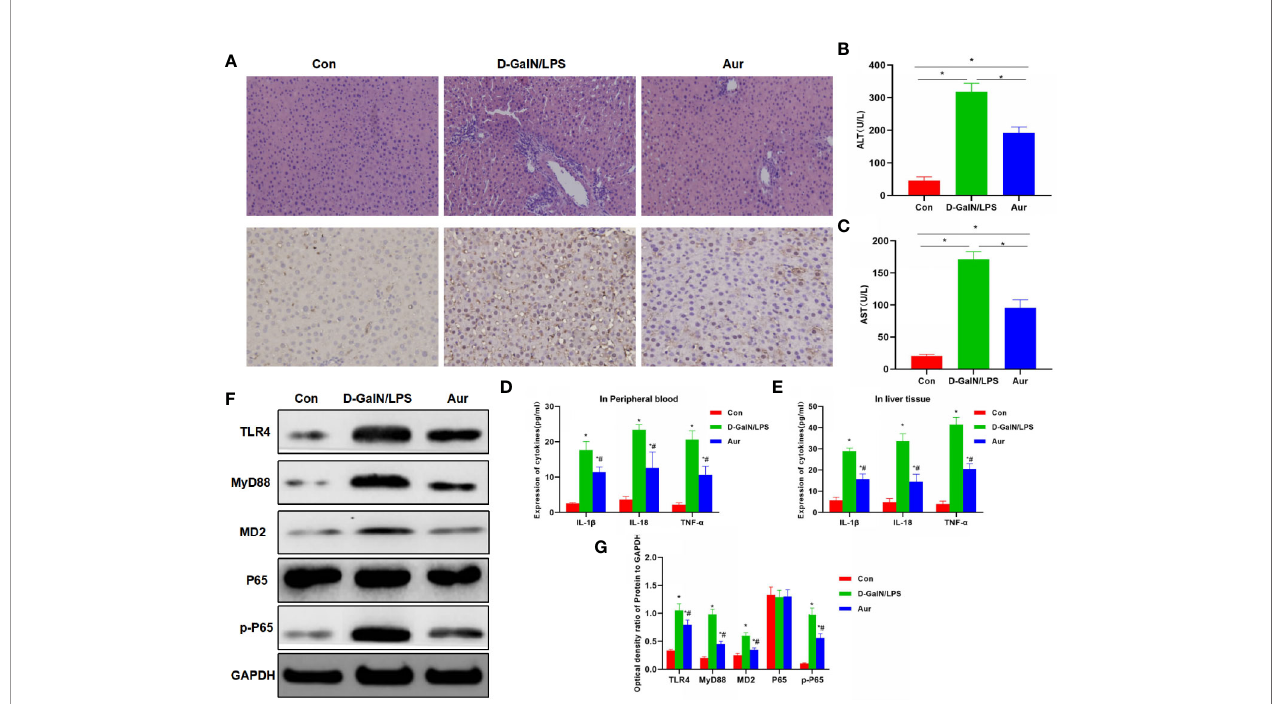
FIGURE 5 | Effect of Aur on ALI in mice. (A) : Effects of Aur on tissue pathology and MD2 expression of liver in mice (n = 5): There was no signi fi cant liver injury in mice from the Con group, with relatively low expression of MD. In the LPS/D-GalN group, there was an in fl ammatory response, tissue edema, and signi fi cantly increased expression of MD2 in the liver tissue, while the tissue in fl ammatory response was relieved and MD2 expression was downregulated in the Aur group. (B, C) : Alteration of ALT and AST expression in mice (n = 10): The expression of ALT and AST was relatively low in the Con group, which was upregulated in the LPS/D-GalN group, but was downregulated in the Aur group. Comparison between groups, *P <0.05. (D, E) : Changes in the expression of in fl ammatory factors in the peripheral blood and liver tissues of mice (n = 10): The expression of in fl ammatory factors, including IL-18, IL-1 b , and TNF- a was relatively low in the Con group, which was upregulated in the LPS/D-GalN group, but was downregulated in the Aur group. Comparison with Con, *P <0.05; comparison with LPS/D-GalN group, # P <0.05. (F, G) : Detection of protein expression in liver tissue from mice (n = 5): The expression of TLR4, MyD88, MD2, and p-P65 was relatively low in the Con group, which was signi fi cantly upregulated in the LPS/D-GalN group, and was inhibited in the Aur group. Comparison with Con, *P <0.05; comparison with LPS/D- GalN group, # P